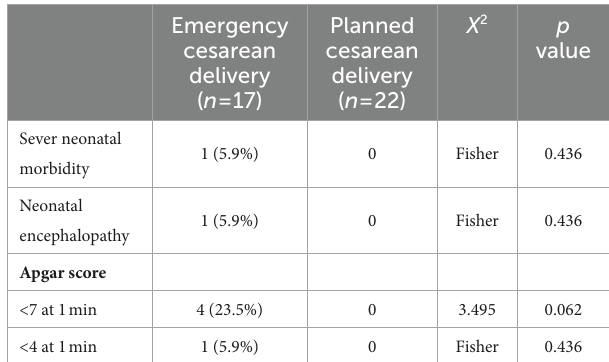
TABLE 5 Primary outcome of term infants in breech presentation between emergency and planned